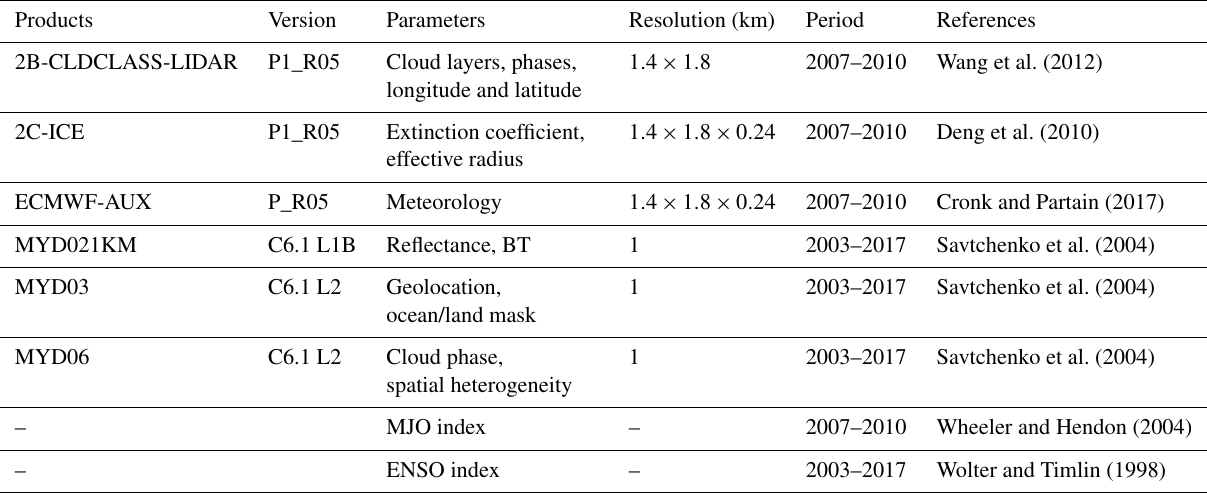
Table 1. Summary of datasets used in this study.